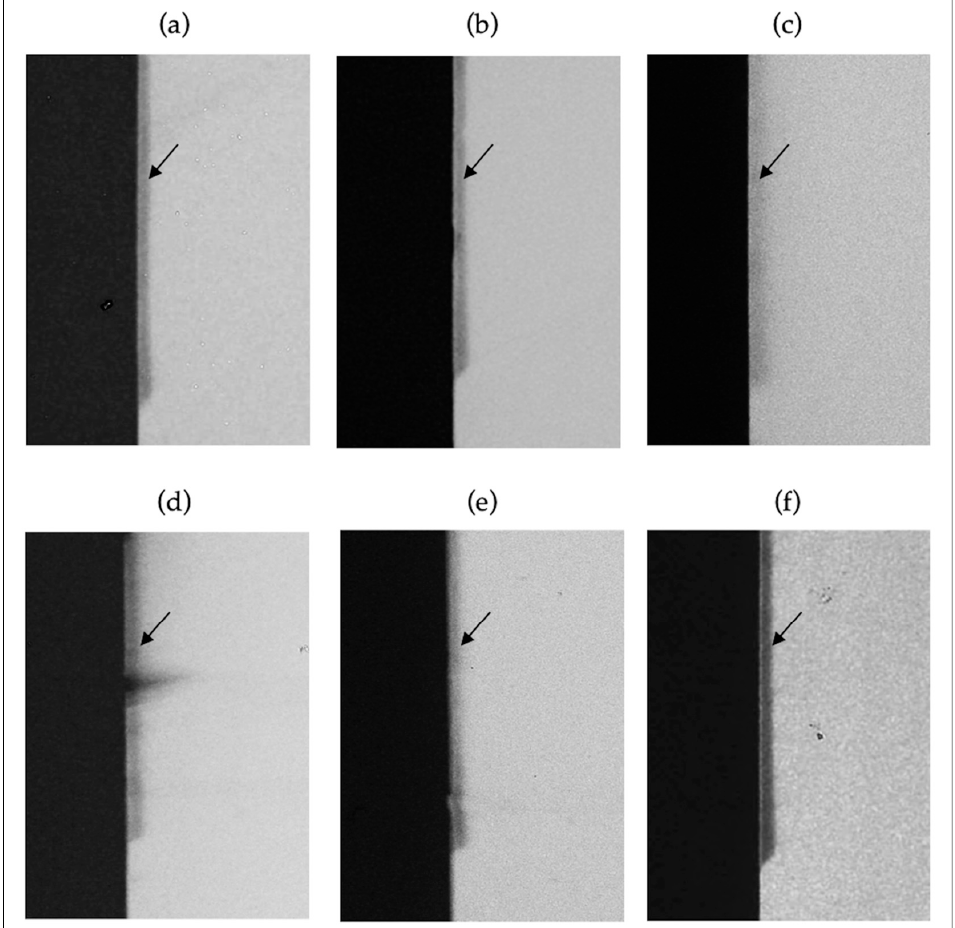
Figure 4. Representative TMR pictures (20×) of the artificial carious enamel lesions created using microcosm biofilm after treatment with different toothpastes. ( a ) Vochysia tucanorum; ( b ) Myrcia bella; ( c ) Matricaria chamomilla; ( d ) Myrrha and propolis toothpaste; ( e ) F and triclosan toothpaste (positive control) ; ( f ) Placebo (negative Control). The black arrow shows the initial caries lesions (darker in color). Placebo showed a more radiolucent area (darker) indicating more enamel demineralization compared to the other groups, which were more radiopaque (brighter), thus, less demineralized. Table 3. Mean ± SD of the integrated mineral loss ( Δ Z, vol% × μ m) and the lesion depth (LD, μ m) of enamel.